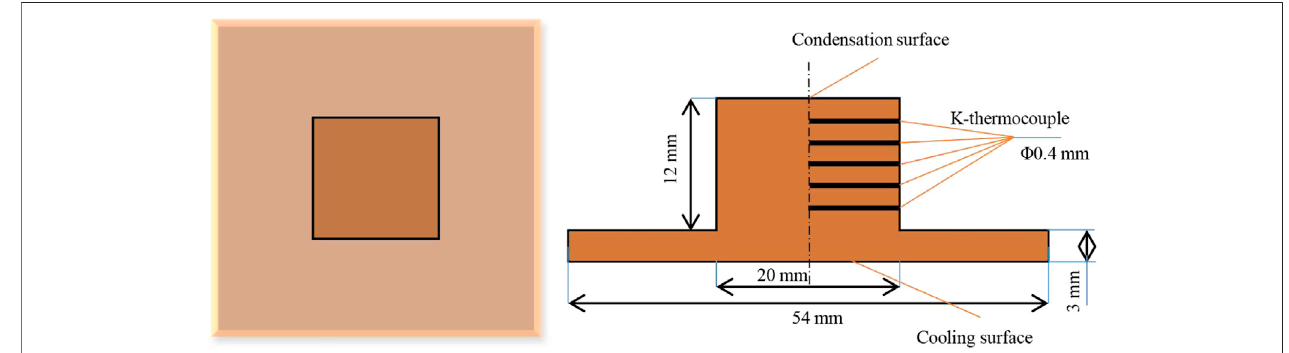
FIGURE 1 | Structure of the brass condensation block and K-thermocouple